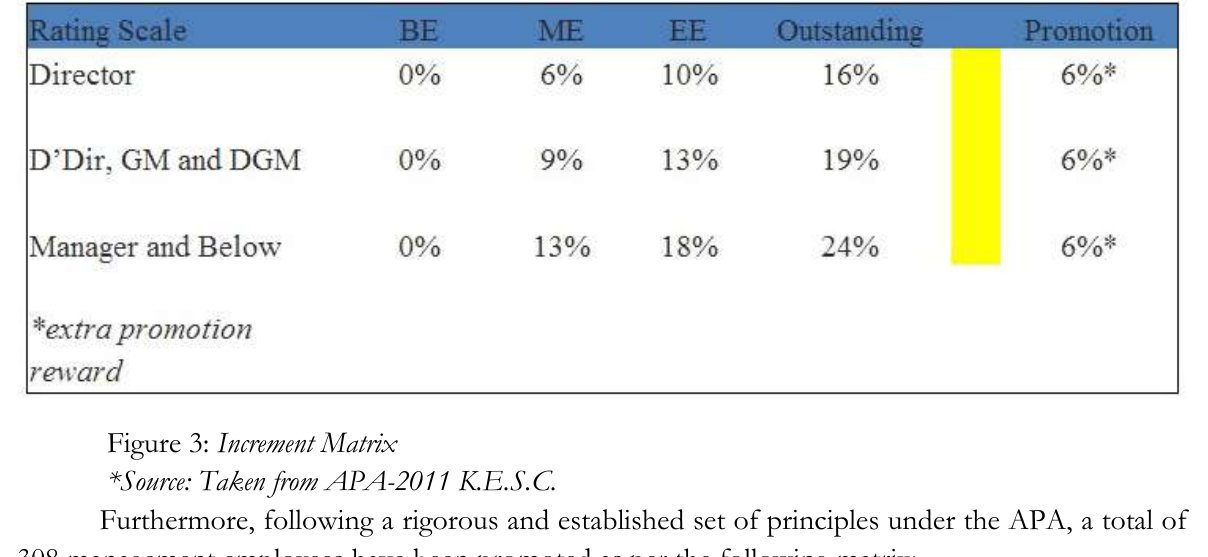
Table 2: Promotion Matrix Levels Total Percentage GM, D’ Dir 4 1% DGM, Manager 65 21% D’Dr Asst Mgr & Officer 239 78% Total 308 100% Source: Taken from APA-2011